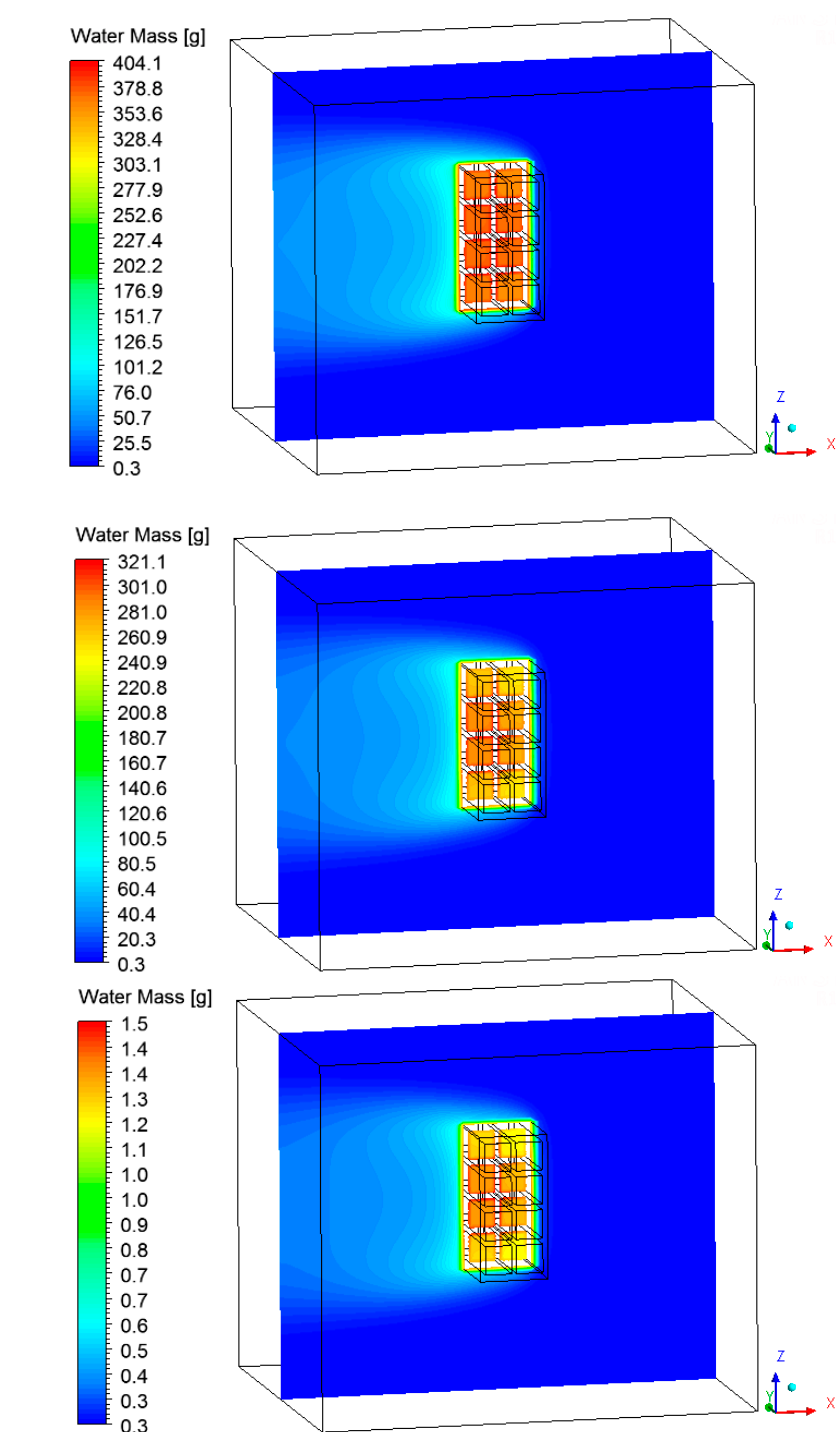
Figure 13. Water mass fields of the air in a plane XZ (Y = 0.1 m) at different moments of drying. ( a ) 10 min, ( b ) 60 min, and ( c ) 950 min.